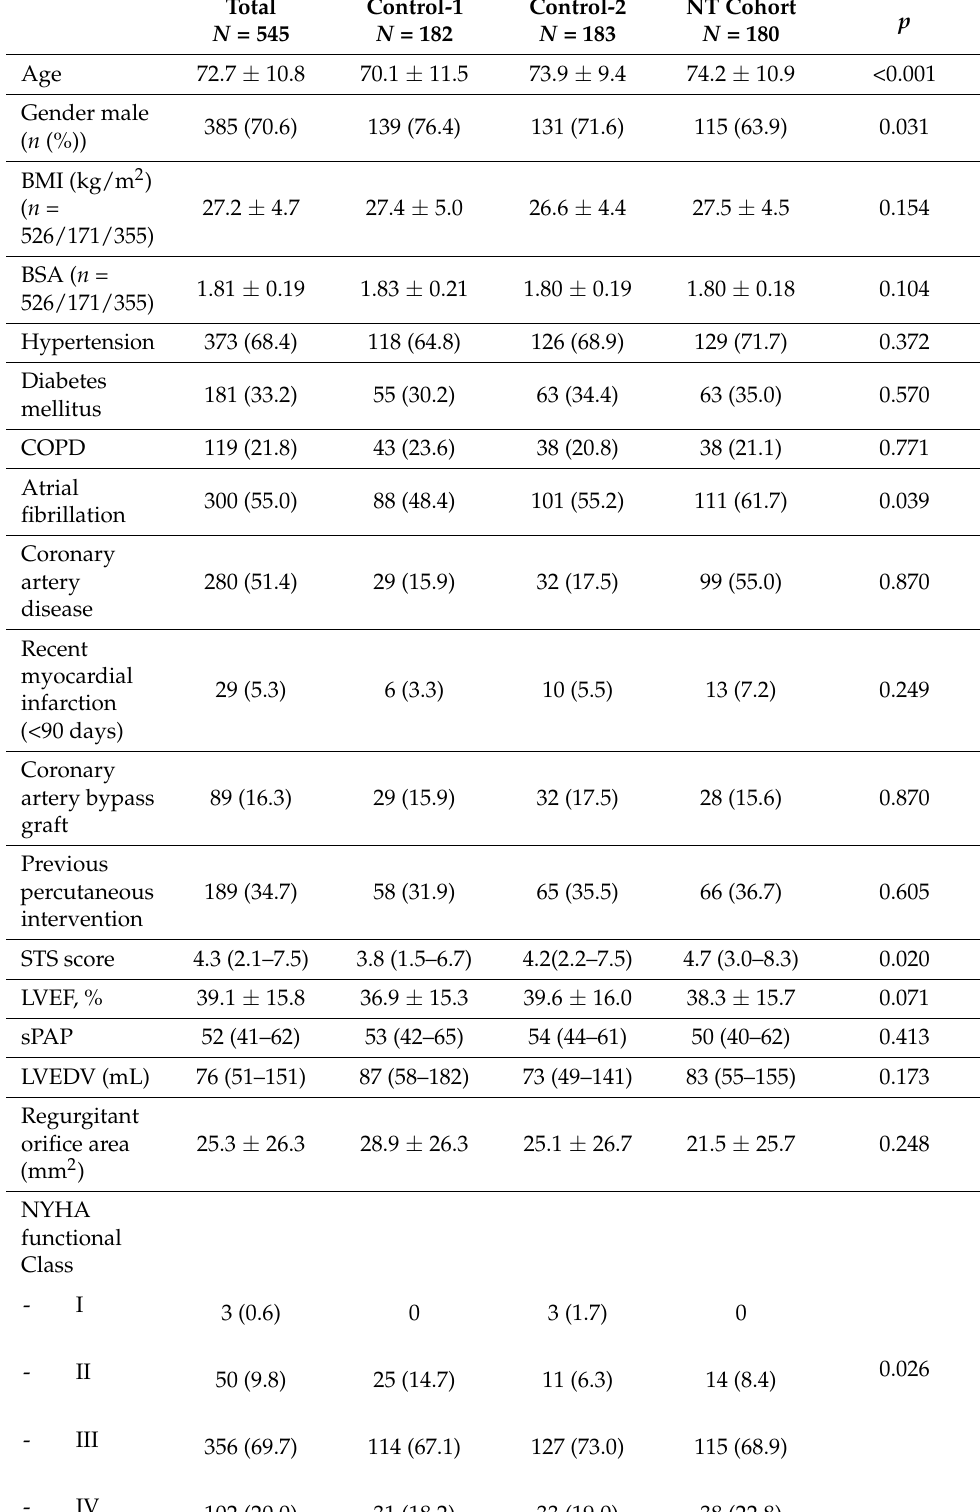
Table 1. Baseline